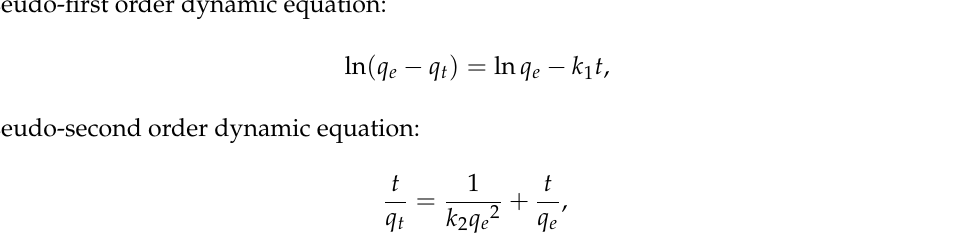
( b ) Figure 10. Pseudo second-order model for adsorption of diesel oil onto: ( a ) CSB; ( b ) CSAB. Table 2. Comparison of the pseudo-first order and pseudo-second order models for the adsorption of diesel oil on crab shell biochar. Sample